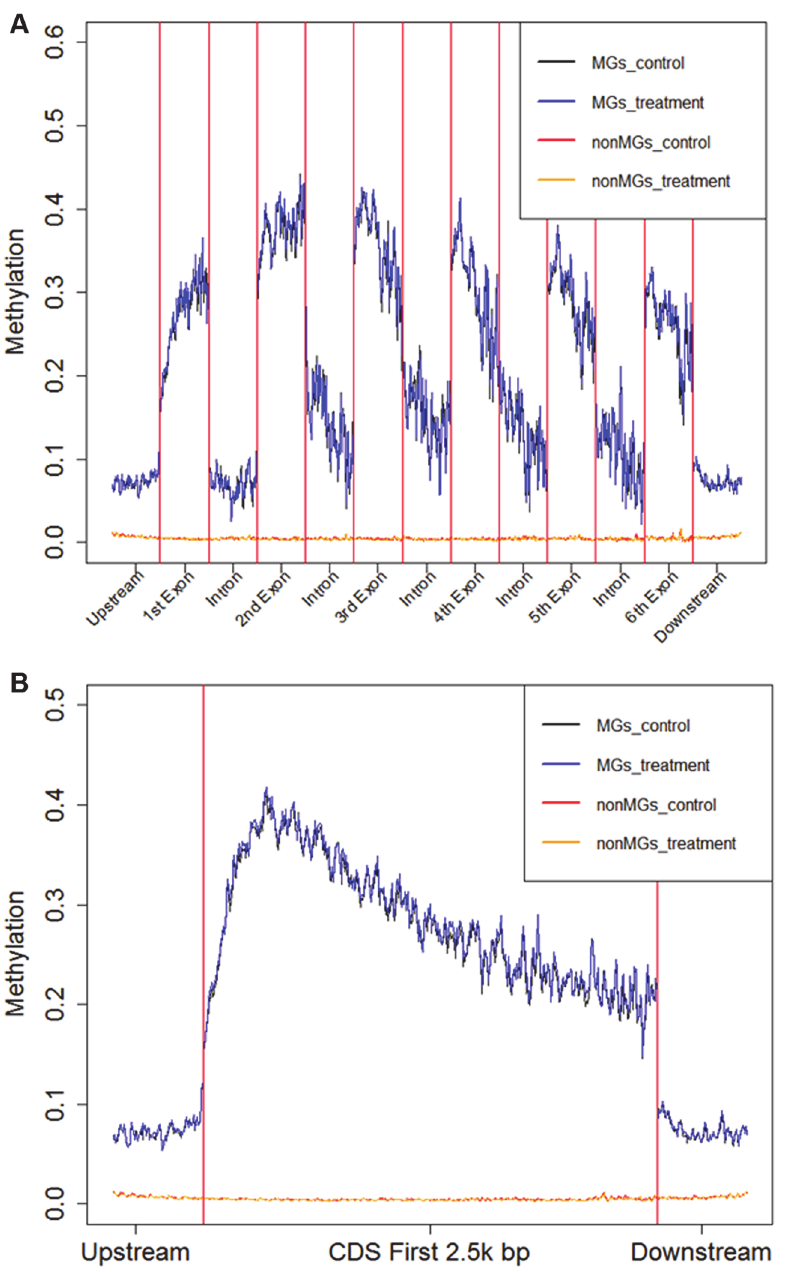
Fig 5. Average fractional methylation levels in different gene regions. A) Average Fractional Methylation level for 1kbp upstream of coding region, first 500bp of first 6 exons, first 500bp of first 5 introns and 1kbp downstream of coding region are shown in the figure. B) Average Fractional Methylation level for 1kbp upstream of coding region, first 3kbp of protein coding region and 1kbp downstream of coding region are shown in the figure. In this figure, the x-axis is the relative coordinate with a word size of 20bp. The y-axis is the average fractional methylation level of CpGs of all genes in a 20bp word (detailed in Materials and Methods). The black line represents the average fractional methylation level for methylated genes in control and the blue line represents the average fractional methylation level for methylated genes in treatment. The red line represents the average fractional non-methylation level for non-methylated genes in control and orange line represents the average fractional methylation level for non-methylated genes in treatment.